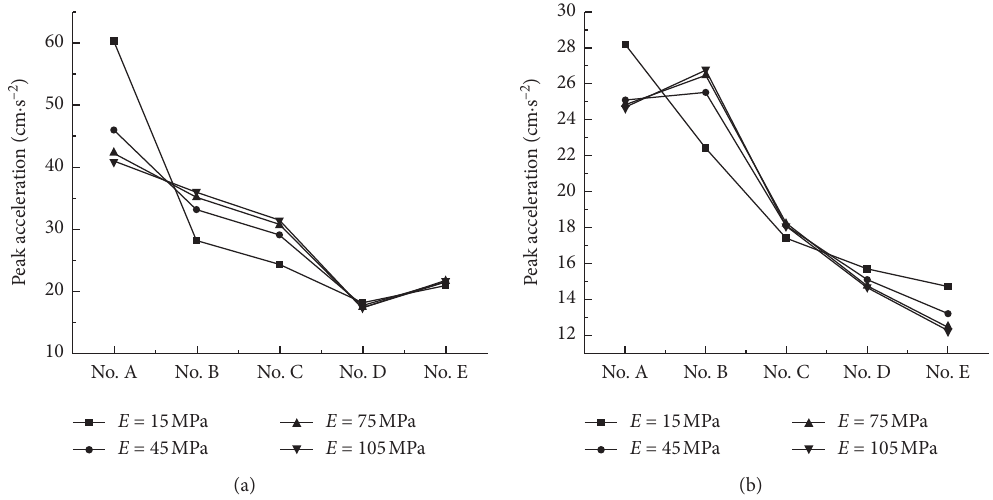
Figure 14: Influence of the elastic modulus of the first terrace on vibration. (a) Horizontal direction. (b) Vertical direction.